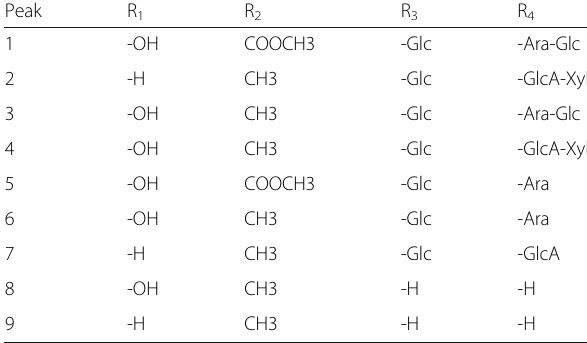
Table 3 The R-group in the structure of each saponin